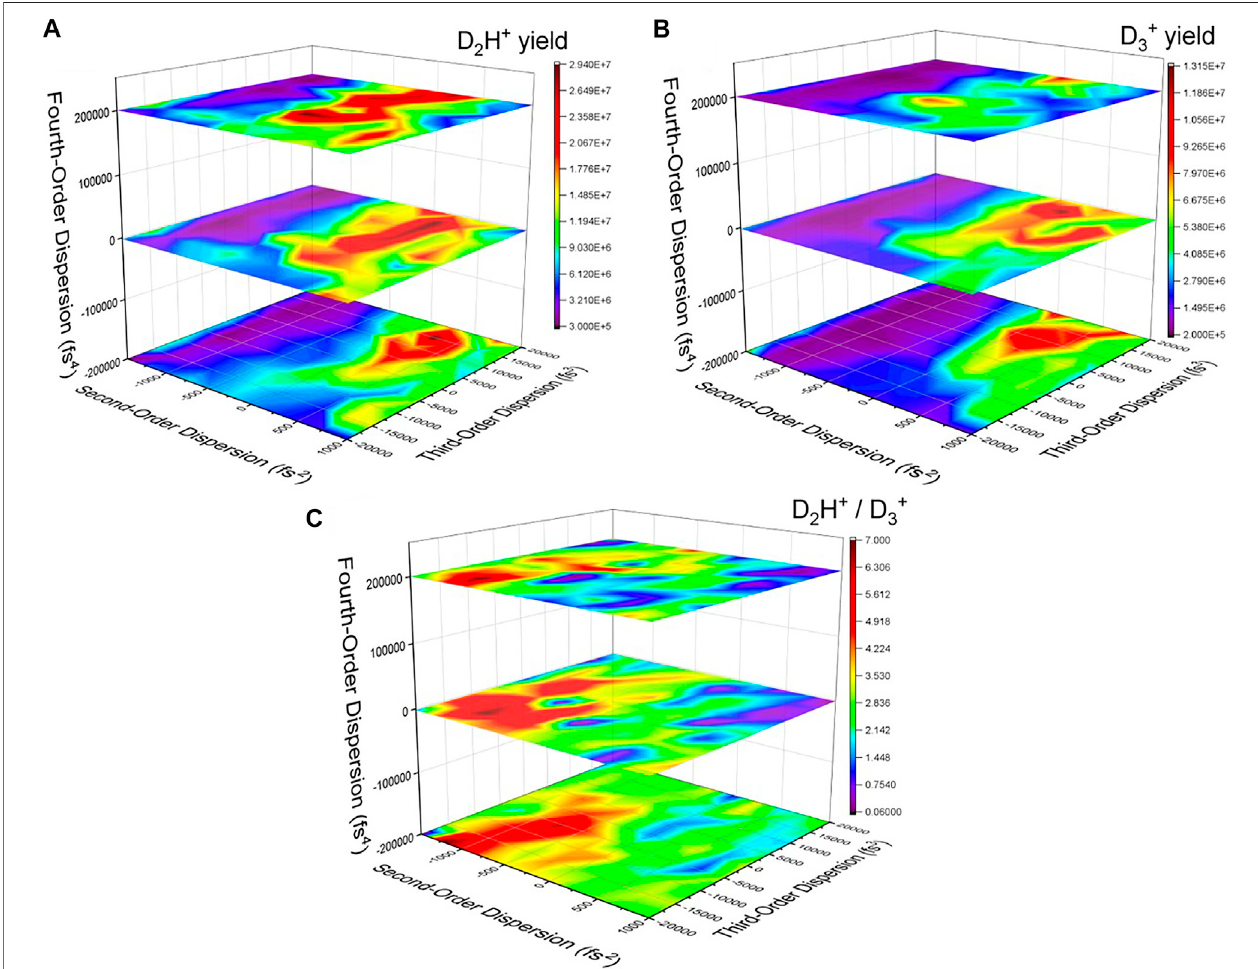
FIGURE 4 | The yield of (A) D 2 H + and (B) D + 3 as a function of second — and third-order dispersion for three values of fourth-order dispersion. In these measurements, the pulse energy is kept constant, so the intensity decreases as the dispersion lengthens the pulses. (C) The D 2 H + :D + 3 ratio as a function of the same pulse parameters. The ratio is de fi ned to be 1.0 at φ ( 2 ) (cid:2) φ ( 3 ) (cid:2) φ ( 4 ) (cid:2)